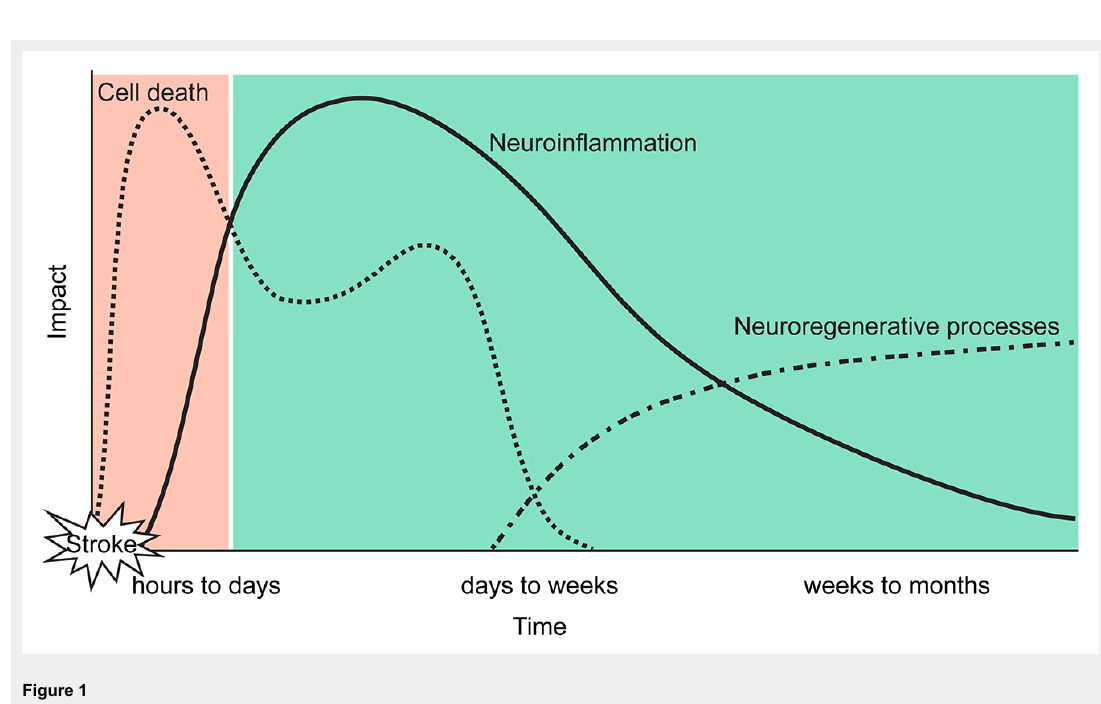
Multiphasic brain interactions after stroke and opportunities for treatment. Previous neuroprotective strategies targeted pathological mechanisms in a very narrow window of opportunity in the (hyper-) acute phase after stroke (orange). Recently, the focus of translational stroke research has shifted towards understanding pathological processes in the subacute and chronic phase such as neuroinflammation and neuroregeneration (green). These targets have the potential for novel therapeutic approaches which are suitable for a larger population of stroke patients then neuroprotective agents or